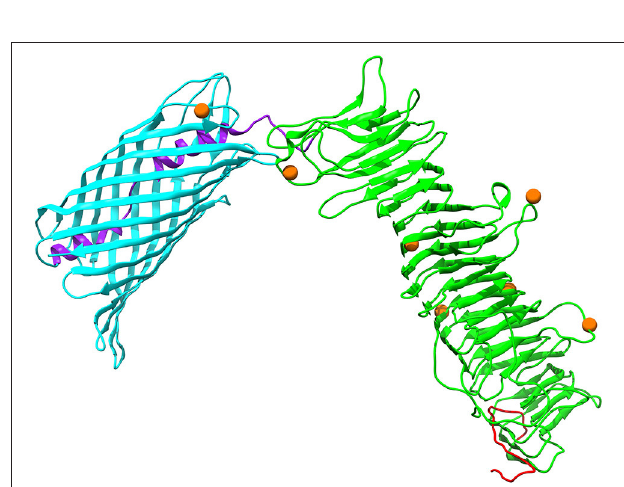
FIGURE 6 | Three-dimensional structural models of the autotransporter protein IcsA. Protein secondary structure is color-coded based on the predicted PFAM domains and signal peptide cleavage site as well as modular organization previously described by Nicolay et al. (2015): an N-terminal signal peptide in red, a secreted mature passenger domain in green, and a C-terminal translocator domain in cyan with an upstream α -helical linker in purple. Orange spheres stand for amino acid residues that are subject to strong positive selection (posterior probability > 95%).